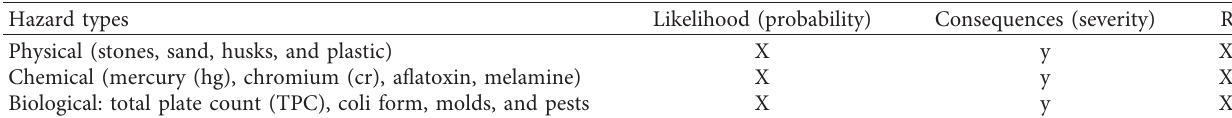
Table 3: Analysis of likelihood vs. consequences.